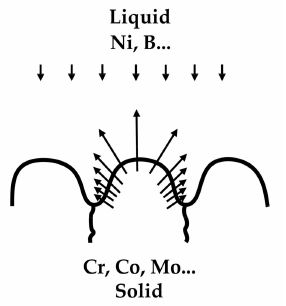
Figure 20. Scheme of cellular growth